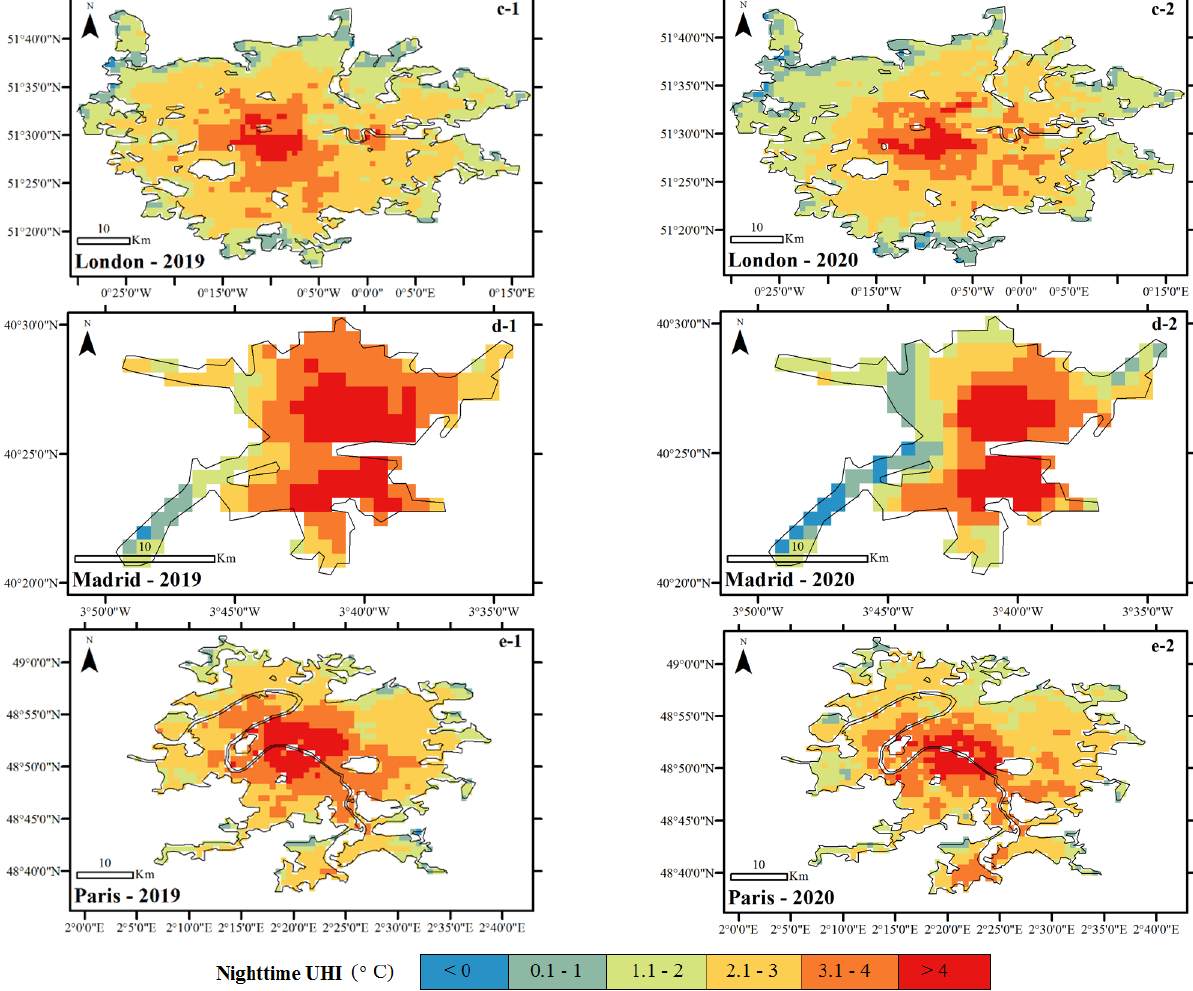
Figure 8. Average NUHI of the studied cities during CSR, extracted from MOD11A2 data in °C. ( a-1 ) Average NUHI of Berlin in 2019, ( a-2 ) Average NUHI of Berlin in 2020, ( b-1 ) Average NUHI of Frankfurt in 2019, ( b-2 ) Average NUHI of Frankfurt in 2020, ( c-1 ) Average NUHI of London in 2019, ( c-2 ) Average NUHI of London in 2020, ( d-1 ) Average NUHI of Madrid in 2019, ( d-2 ) Average NUHI of Madrid in 2020, ( e-1 ) Average NUHI of Paris in 2019, ( e-2 ) Average NUHI of Paris in 2020.